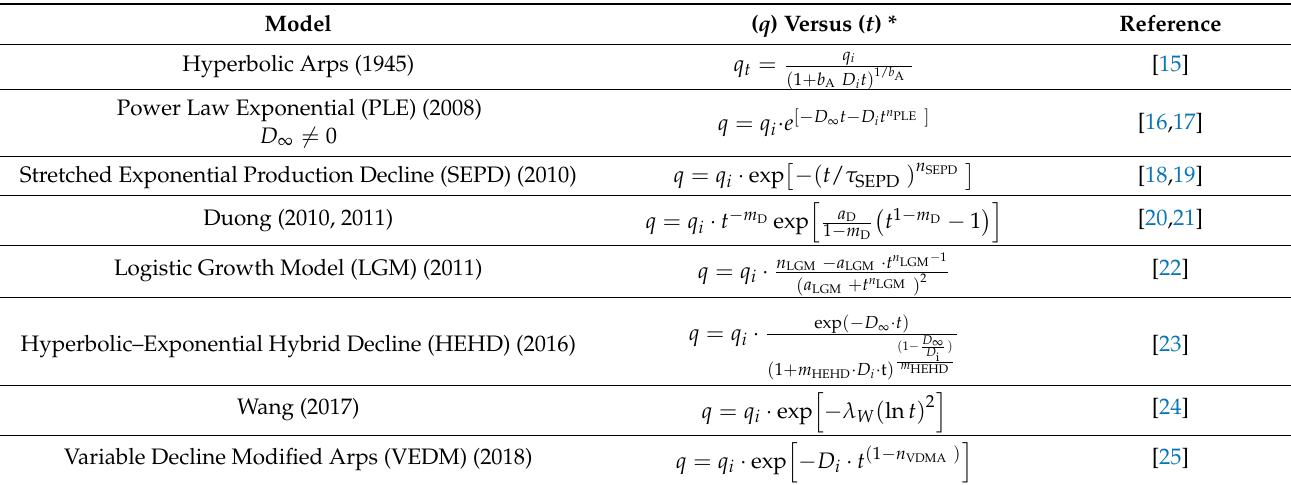
Figure 1. Summary of the uncertainties related to DCA. Table 1. Formulas of the DCA models used in this